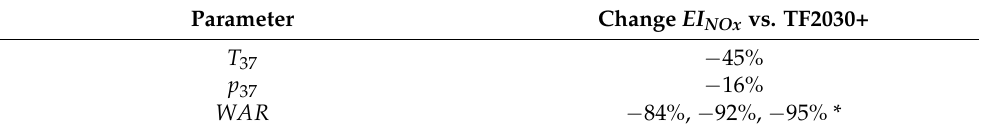
Table 3. Change in EI NO in WET concept vs. TF2030+ separated by each influence parameter. x Parameter Change EI NOx vs. TF2030+ T 37 − 45% p 37 − 16% WAR − 84%, − 92%, − 95% * * 50%, 75%, 100% of overall WAR in the primary zone for NO x